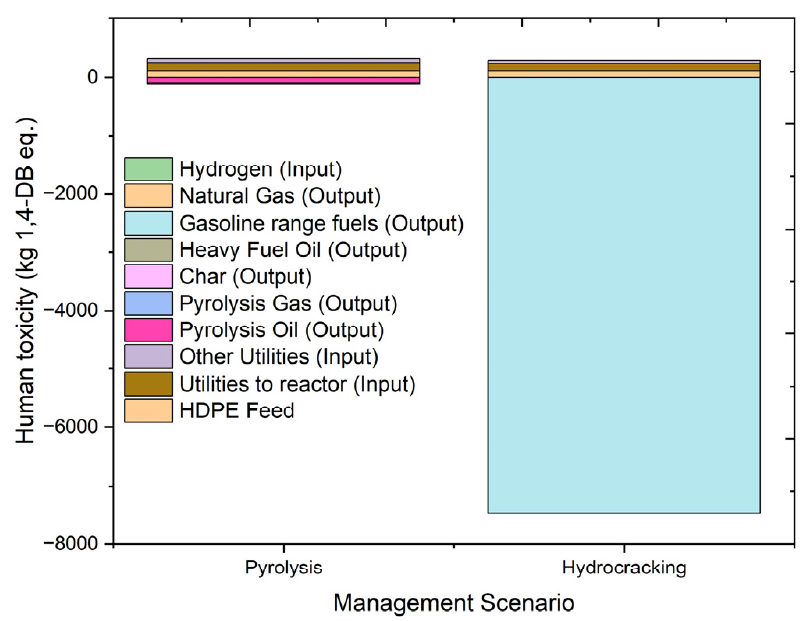
Figure 11. Impact assessment of pyrolysis and hydrocracking for the management of waste HDPE on human toxicity (kg 1,4-DB eq.).